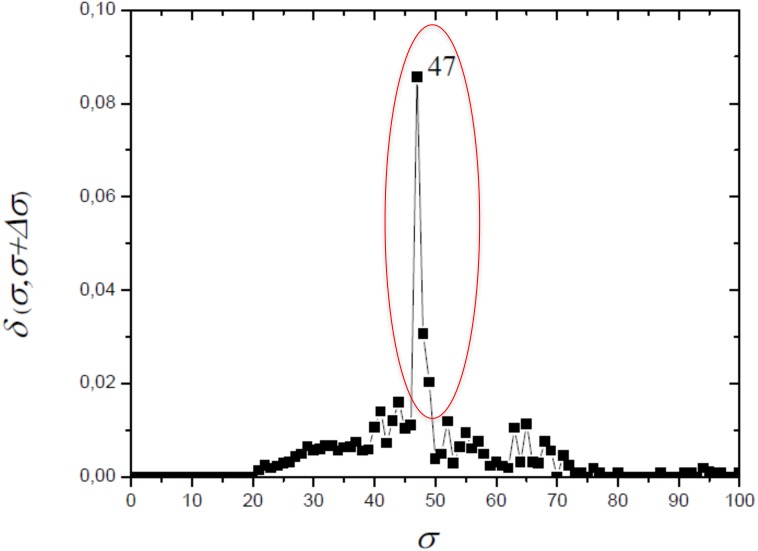
The distance δ(σ, σ + Δσ) between networks for successive similarities at the maximal value with Δσ = 1.The optimum value of similarity (critical similarity) used to retrieve the phylogenetic relations (Andrade et al., 2011).